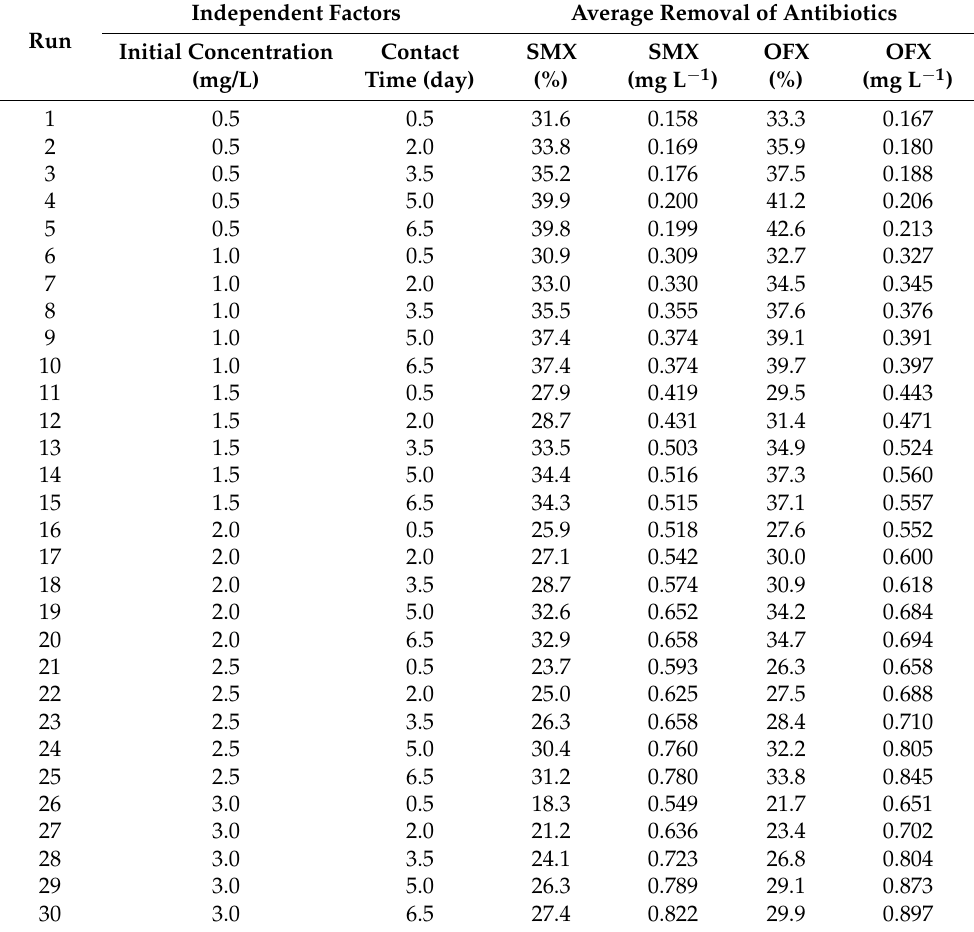
Table 3. Response values for different independent